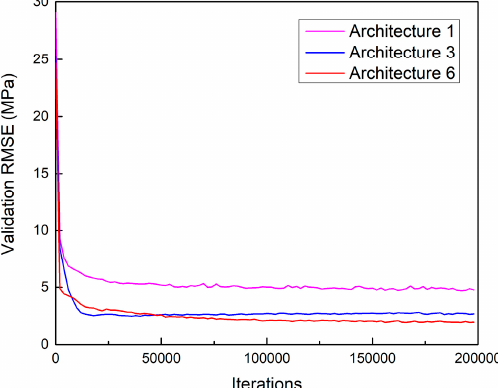
Figure 8. Relationship between validation RMSE and iterations.